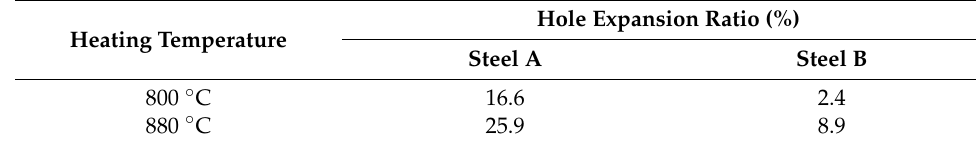
Table 7. HER of steel A and B under different temperatures.